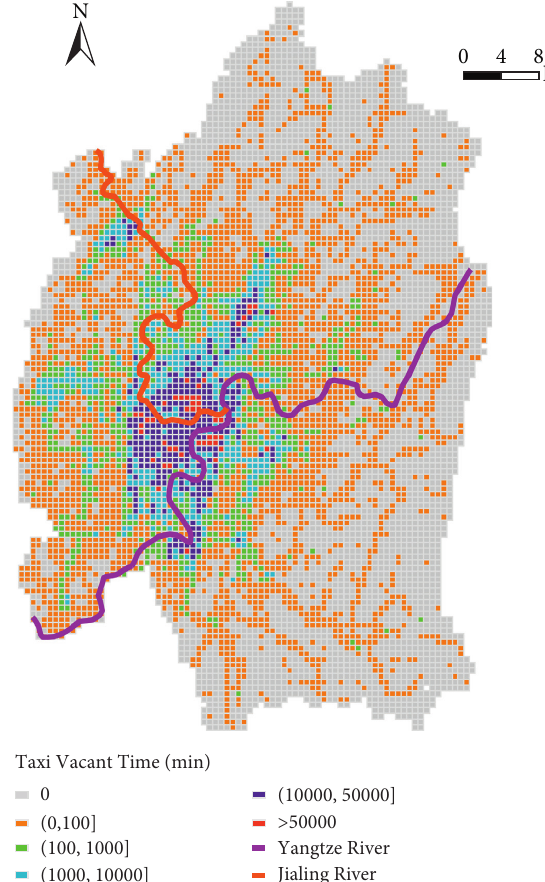
Figure 3: Kernel Density Map of total taxi vacant time in